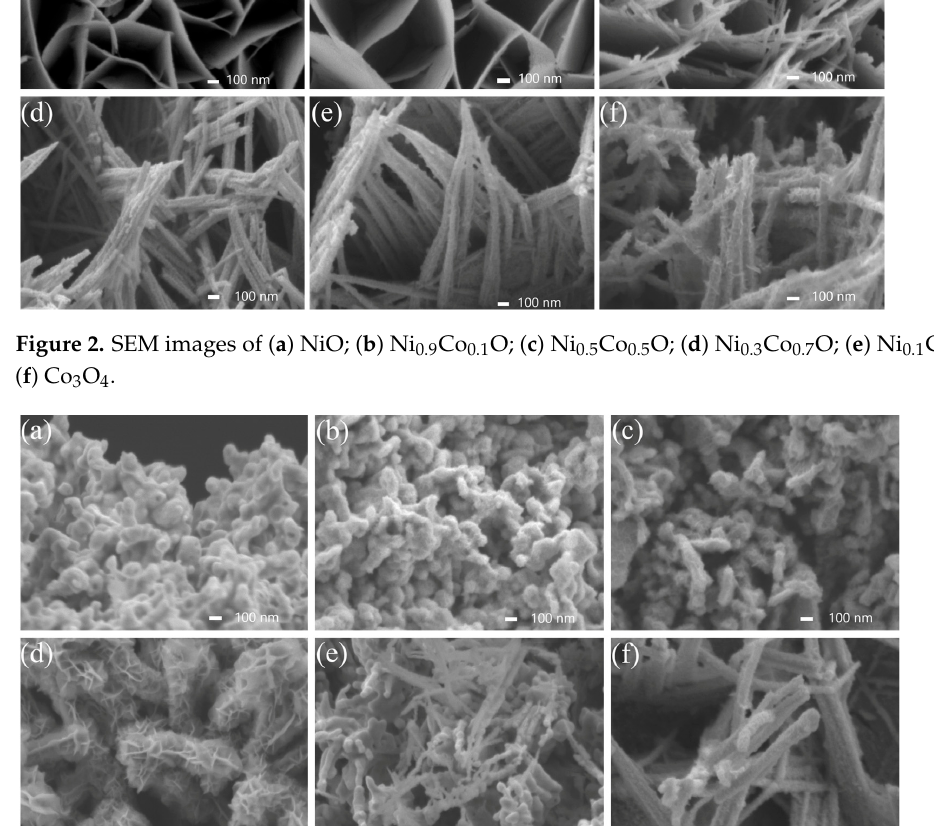
Figure 5. ( a ) TEM; ( b ) HRTEM and ( c ) elemental-mapping images of Ni 0.3 Co 0.7 N. 2.2. Crystal Structure and Composition To investigate the crystal structure and phase information of all the oxide and nitride catalysts, X-ray diffractometry measurements were carried out. The prepared metal ox- ides and nitrides on nickel foams all show clear and strong signals in the XRD patterns, revealing the successful synthesis of the catalysts. As shown in Figure S8, the characteristic peaks of nickel-oxide patterns are well indexed to those of cubic NiO [JCPDS: 78-0643], and the peaks of cobalt oxide are assigned to the structural phase of Co 3 O 4 [JCPDS: 80- 1533] [31]. With the molar ratio of Ni and Co changing, the XRD patterns of Ni x Co 1 − x O show the features of the combination of NiO and Co 3 O 4 , inconsistent with the HRTEM results. From the comparison of XRD patterns in Figure 6, the transformation of the oxides and nitrides can be clearly observed. The strong signals at 44.6°, 51.9° and 76.5° can be ascribed to the nickel-foam substrate (JCPDS No.70-0989). After thermal nitridation under NH 3 atmosphere, the XRD patterns of nickel nitride match well with the structural phase of Ni 3 N [JCPDS:10-0280], and the peaks of cobalt nitride are assigned to the Co 2 N 0.67 struc- tural phase [JCPDS:06-0691] (Figure S9) [45], which matches well with the HRTEM results. The XRD patterns of Ni x Co 1 − x N show the features of the combination of Ni 3 N and Co 2 N 067 . The XRD results confirm the successful synthesis of the cobalt- and nickel-based bimetallic oxides and the nitrides composites from the calcination reaction in different atmospheres of hydrothermal precursors. In addition, the XRD patterns of Ni 0.3 Co 0.7 N after the OER